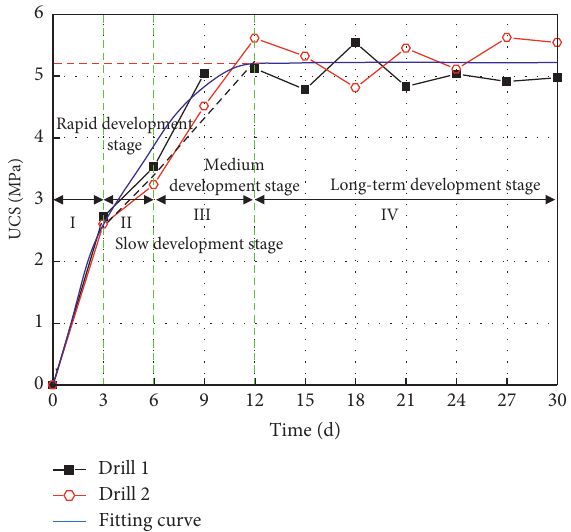
Figure 6: Development of UCS with the underground curing